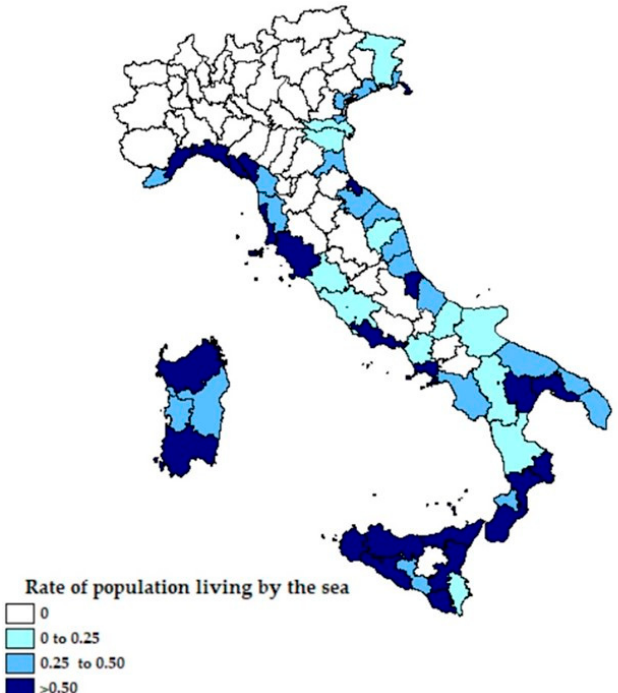
Figure 3. Rate of population living by the sea for each Italian province.